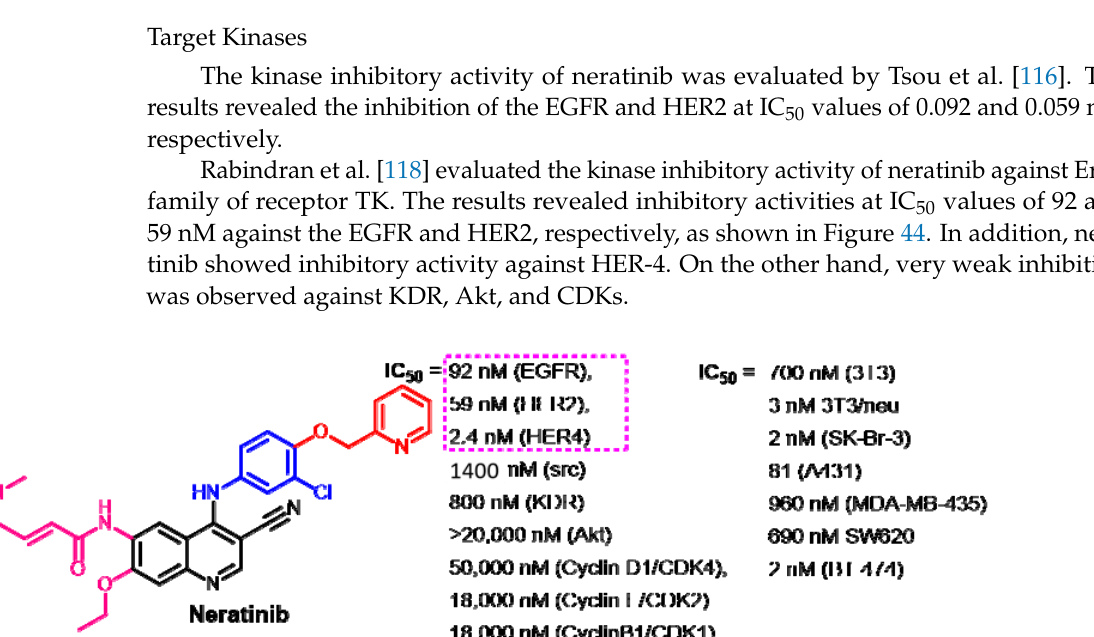
Figure 45. Binding modes of neratinib (shown as sticks) into EGFR kinase domain T790M mutation (pdb: 2JIV): ( A ) 3D binding mode, receptor shown as hydrogen bond surface; ( B ) 2D binding mode showing the covalent bond with Cys797 and the hydrogen bond interactions; the figure was generated using Discovery Studio Visualizer (V16.1.0.15350).